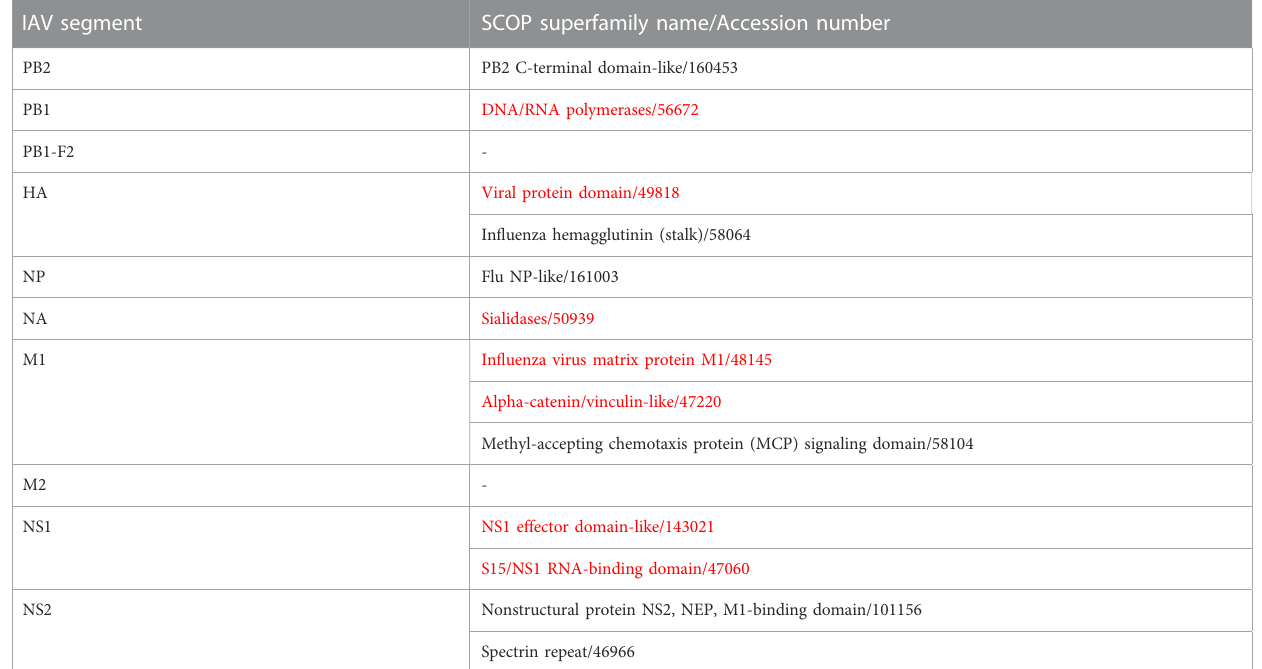
TABLE 3 IAV Domains identi fi ed by SCOP Superfamily. Red indicates domains identi fi ed as interacting with mouse proteins, while ‘ - ’ indicates no identi fi ed